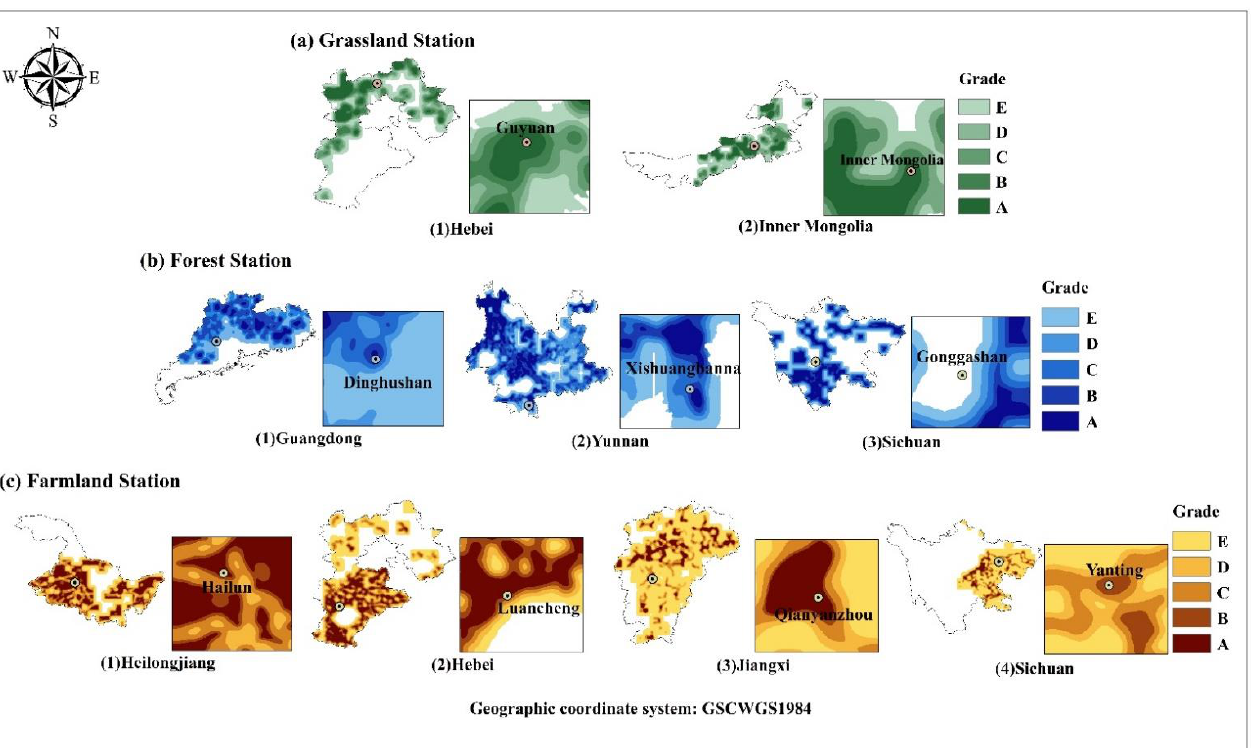
Figure 5. Test stations score density map: ( a ) represents grassland stations, it includes Guyuan S. and Inner Mongolia S.; ( b ) represents forest stations, it includes Dinghushan S., Xishuangbanna S. and Gonggashan S.; ( c ) represents agricultural station, it includes Hanlun S., Luancheng S., Qianyanzhou S., and Yanting S. The depth of the color represents the grade of score.